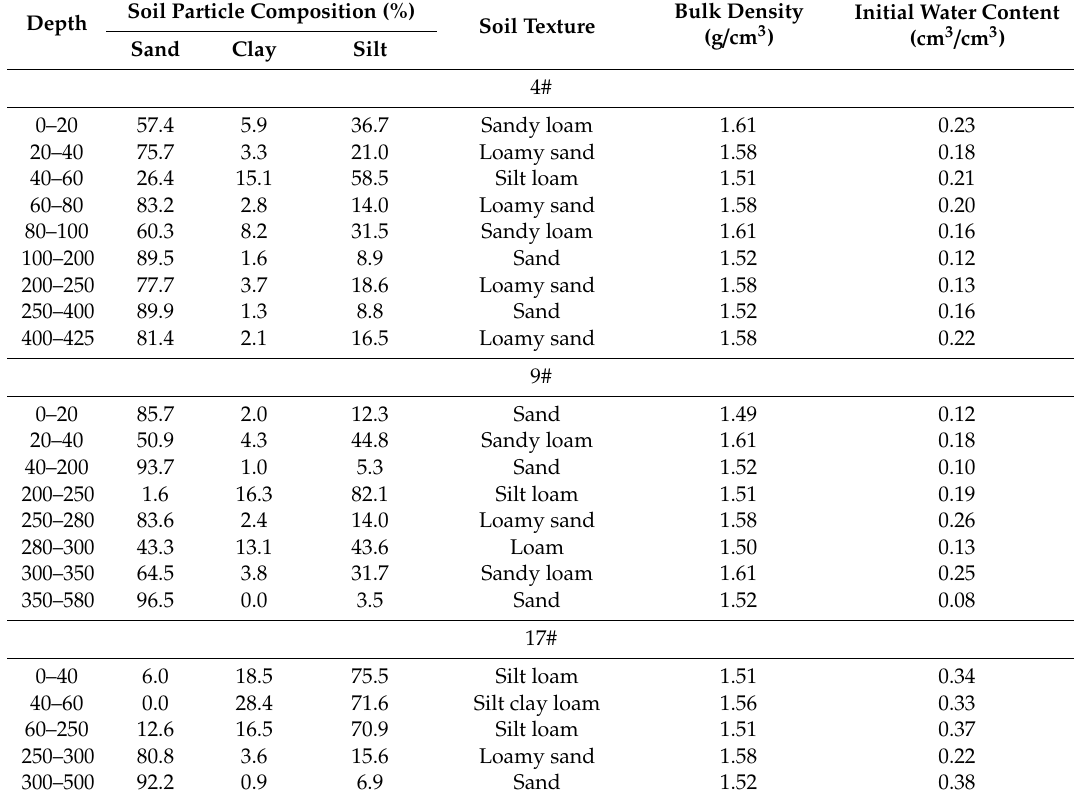
Table A1. Soil physical properties of 4#, 9# and 17# test